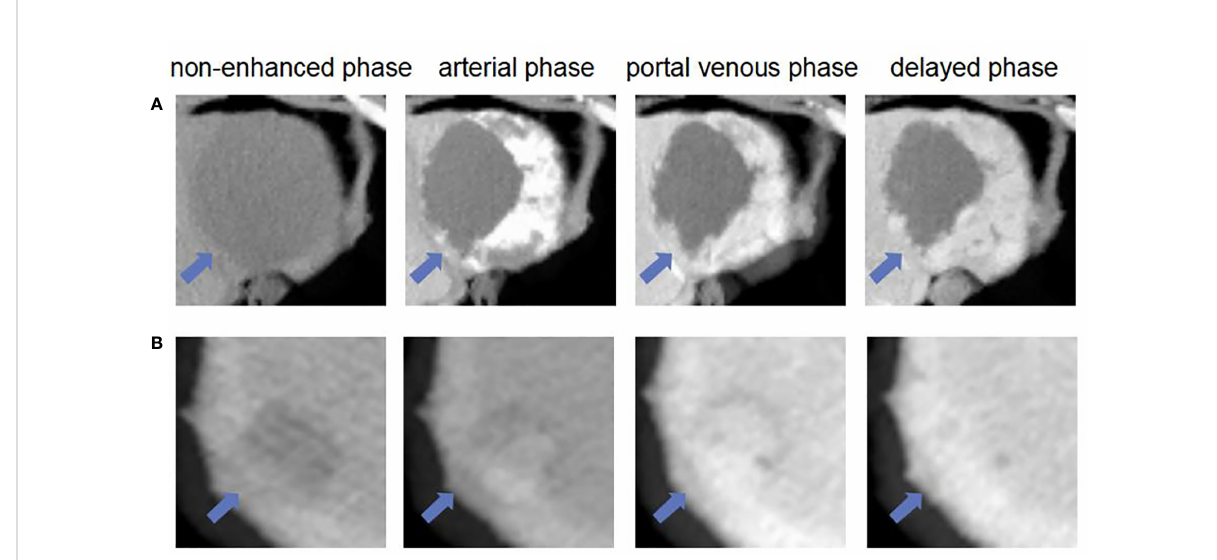
FIGURE 4 The liver masses misdiagnosed by models. (A) shows four phase images of a 62-year-old man with a hemangioma (arrow) that was diagnosed through one-year follow-up in 2018. The mass was correctly diagnosed as non-HCC by using enhanced model and our MExPale model. It was misdiagnosed as HCC by using basic model. (B) shows four phase images of 54-year-old man with a HCC (arrow) that was diagnosed after surgery. The mass was correctly diagnosed as HCC by using our MExPale model. It was misdiagnosed as HCC by using basic model and enhanced